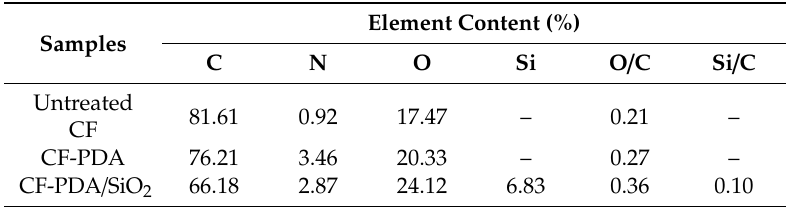
Table 1. Surface element analysis of carbon fibers